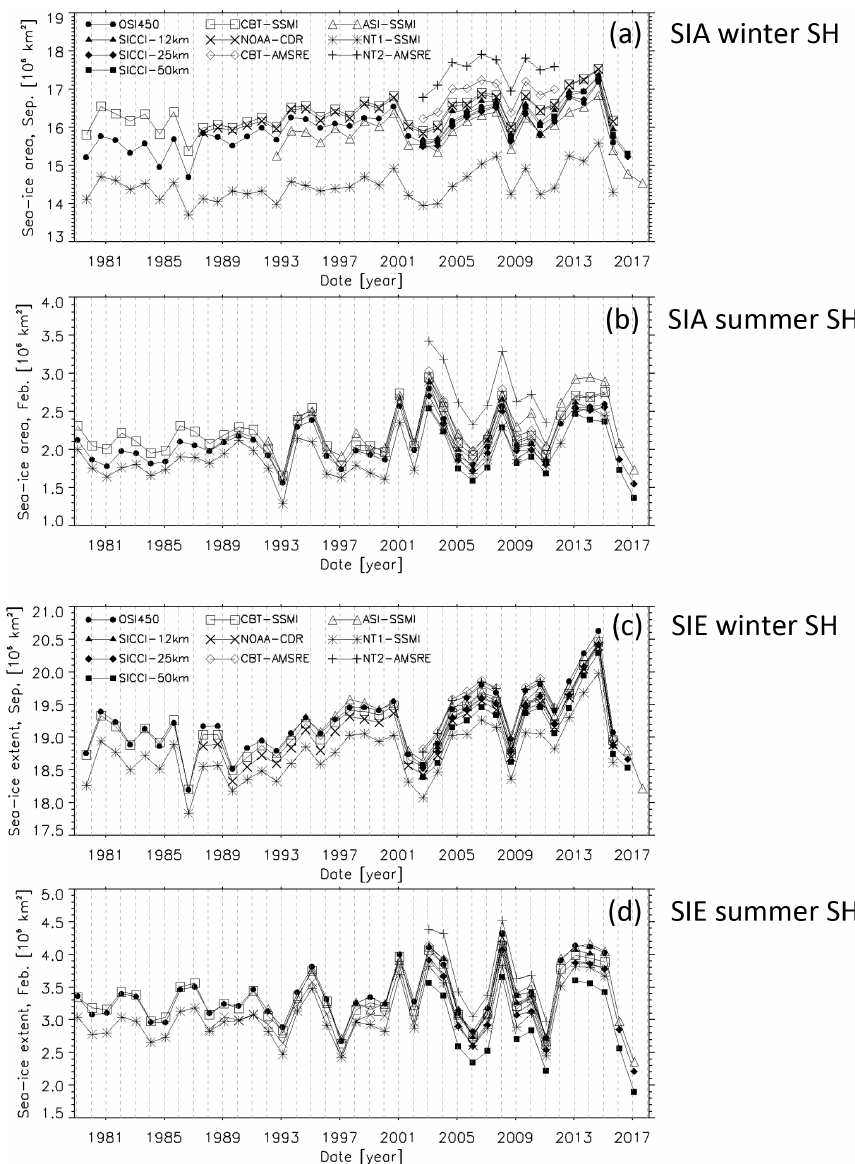
Figure 7. As Fig. 6 but for the